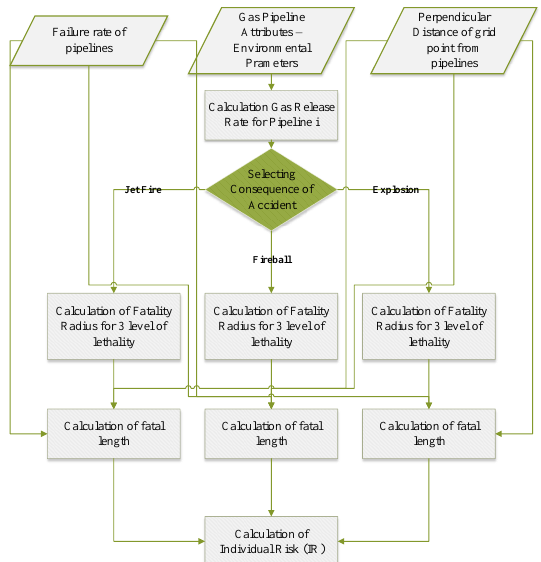
Figure 2. Process of quantitative risk